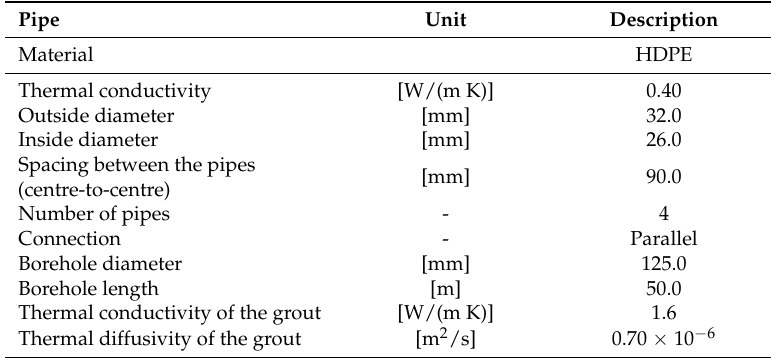
Table 3. Characteristics of the double U-tube borehole heat exchangers (Borehole